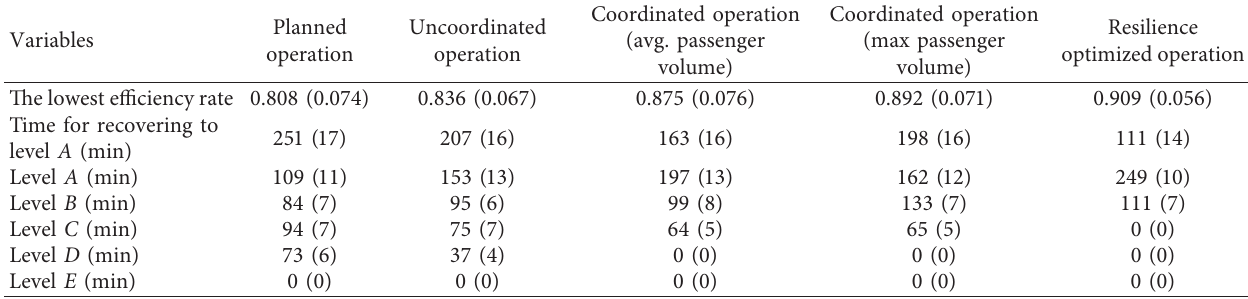
Table 5: Comparison of optimization methods based on levels of system efficiency rate.